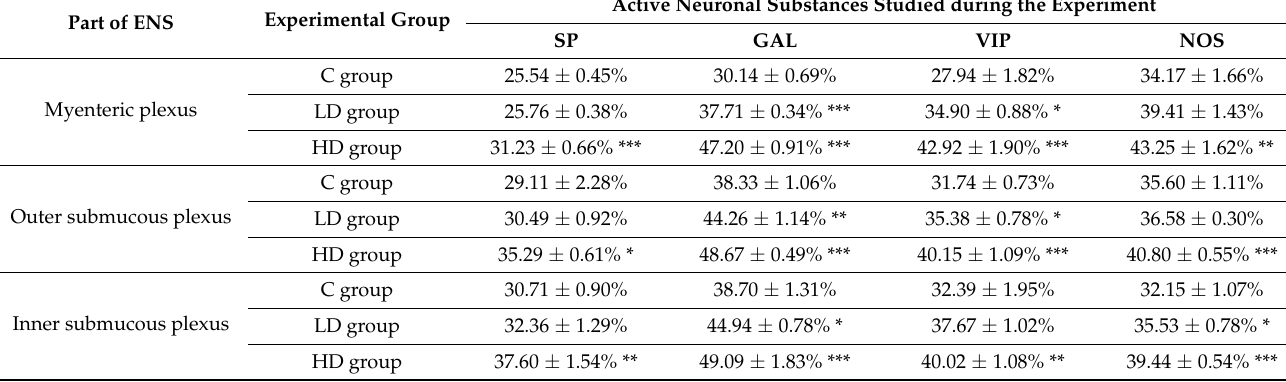
NRG1-positive neurons were considered as representing 100% for all combinations with selected neuronal factors, and all the values presented are percentages (means ± SEM) of NRG1-positive enteric neurons. Statistically significant ( p ≤ 0.05) and highly statistically significant ( p ≤ 0.01 and p ≤ 0.001) differences between the C group and LD group, as well as the C group and HD group, are marked with *, ** and ***,